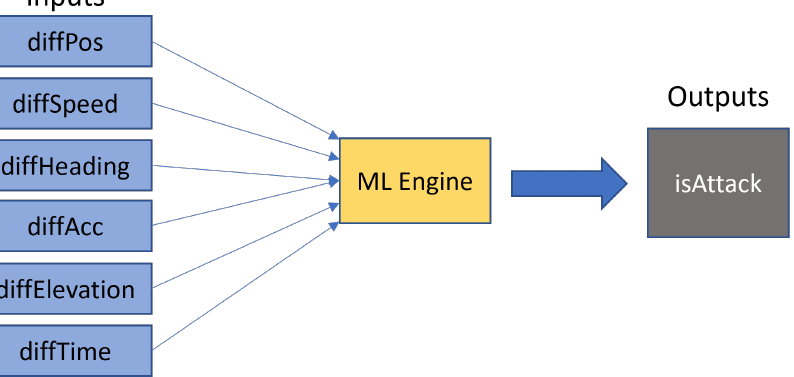
Figure 7. Inputs and Ouputs of ML